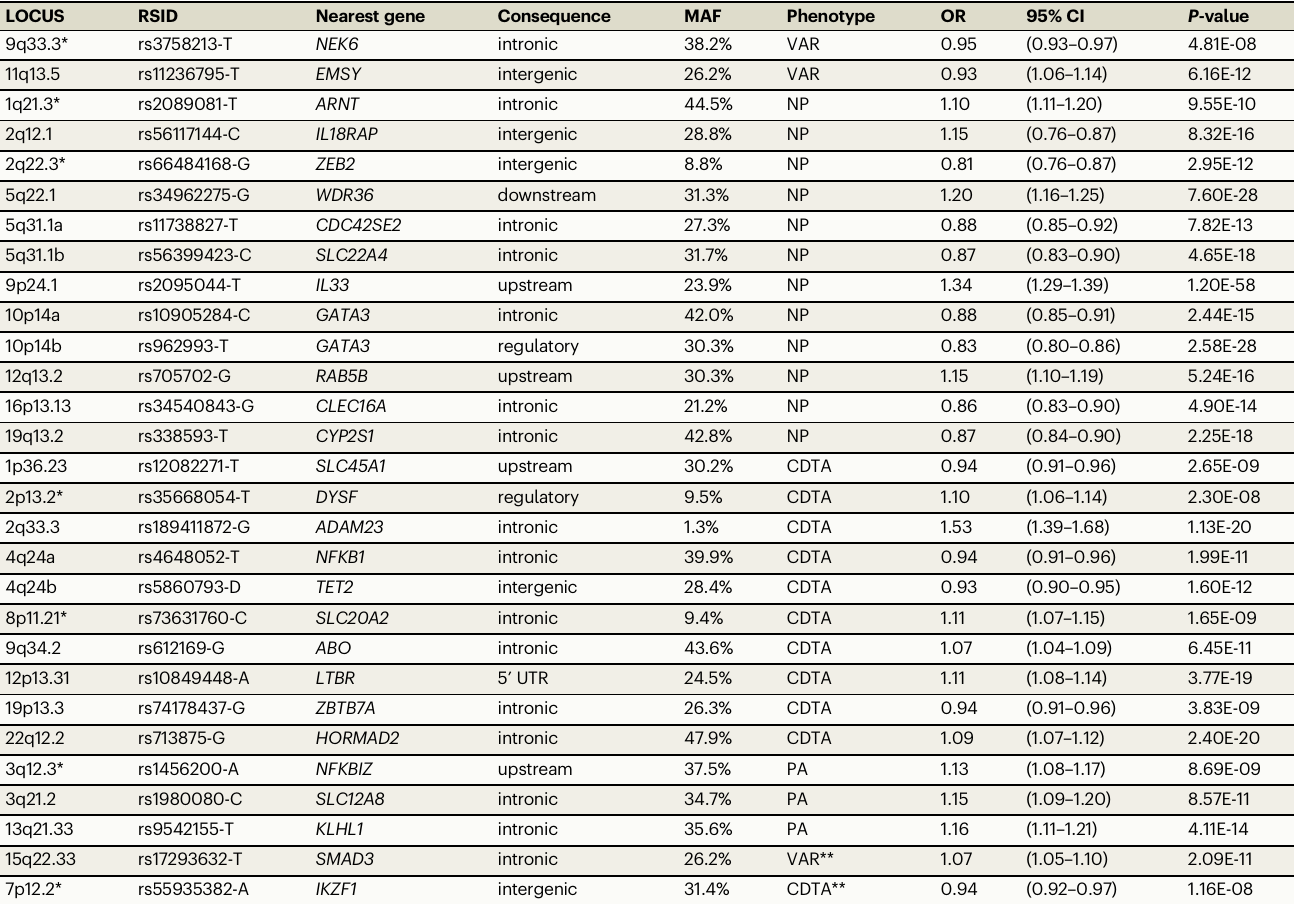
Table 2 | Inverse-variance-weighted meta-analysis of loci lead variants with similar effect in FinnGen and UKB LOCUS RSID Nearest